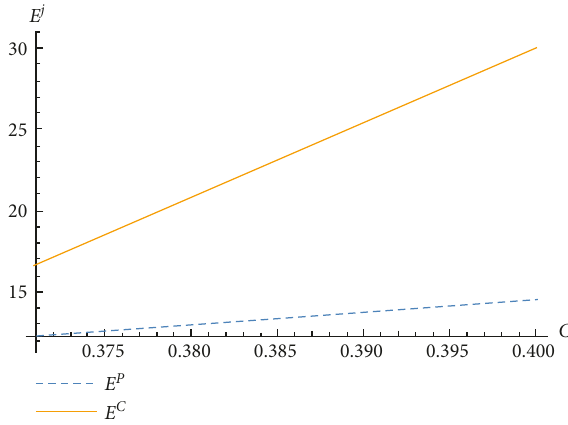
Figure 2: Environmental outcomes: effects of c